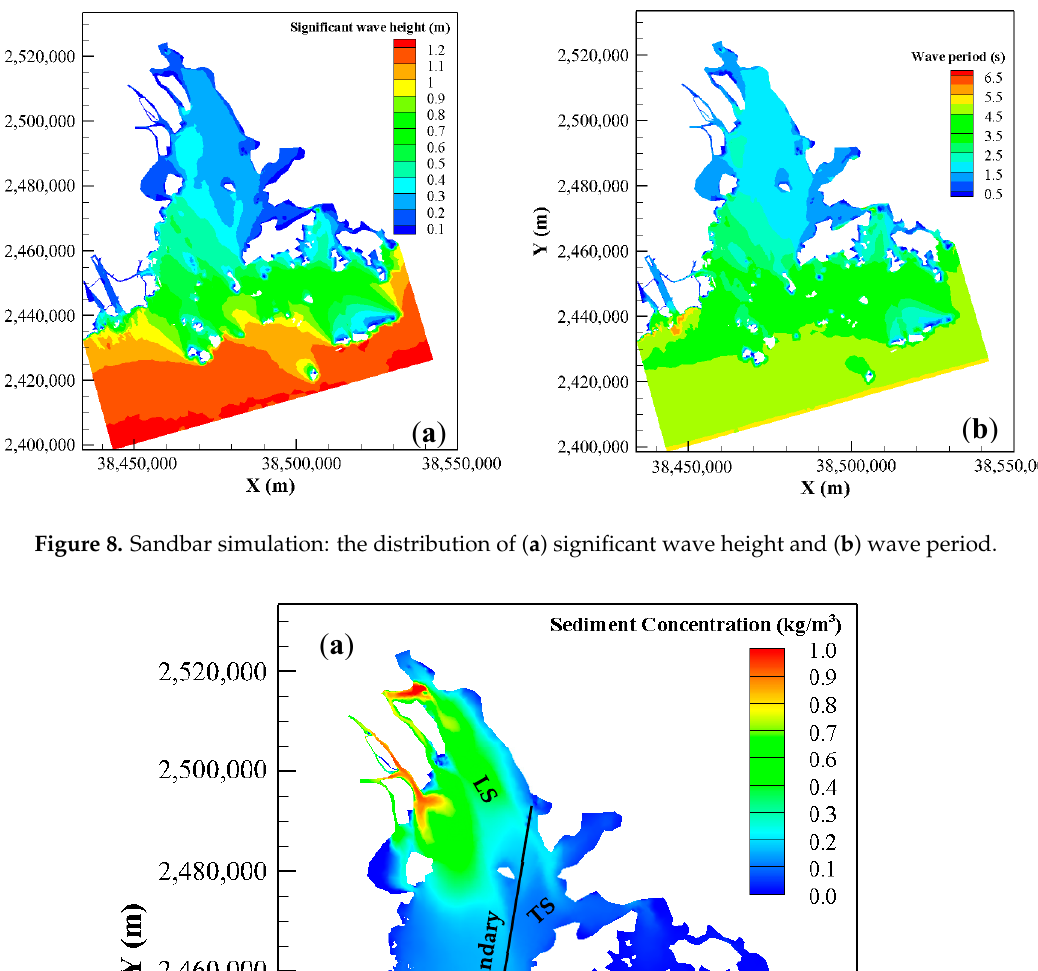
Figure 8. Sandbar simulation: the distribution of ( a ) significant wave height and ( b ) wave period.